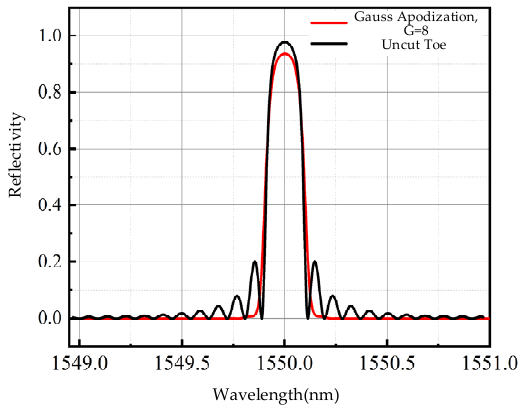
Figure 8. Grating reflection spectra of uncut toe and Gaussian toe (G = 8).